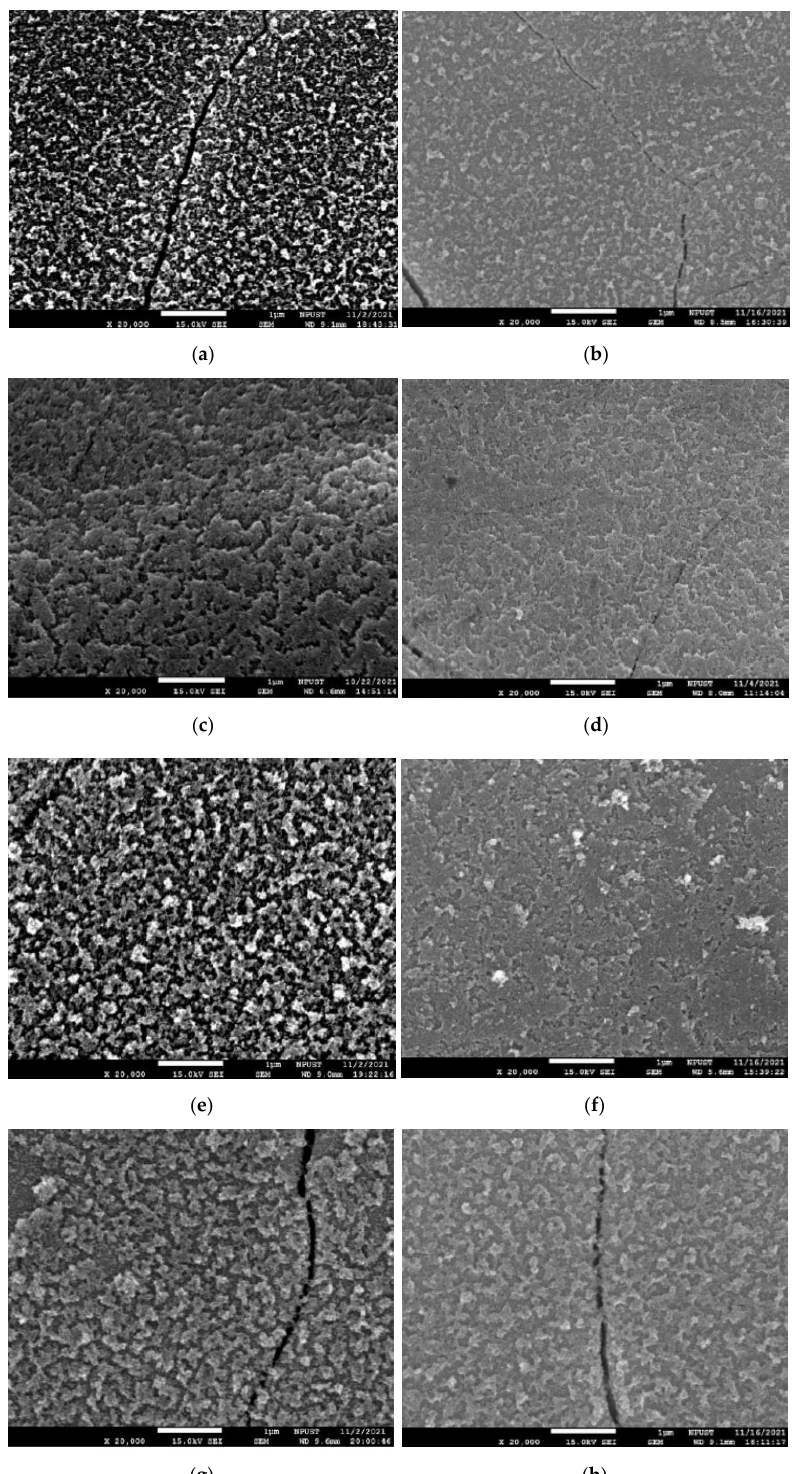
Figure 6. The roughness and contact angle of the CP-Ti and Ti64 samples for ( a ) N0 and ( b ) N20 after laser surface modification in an air atmosphere.